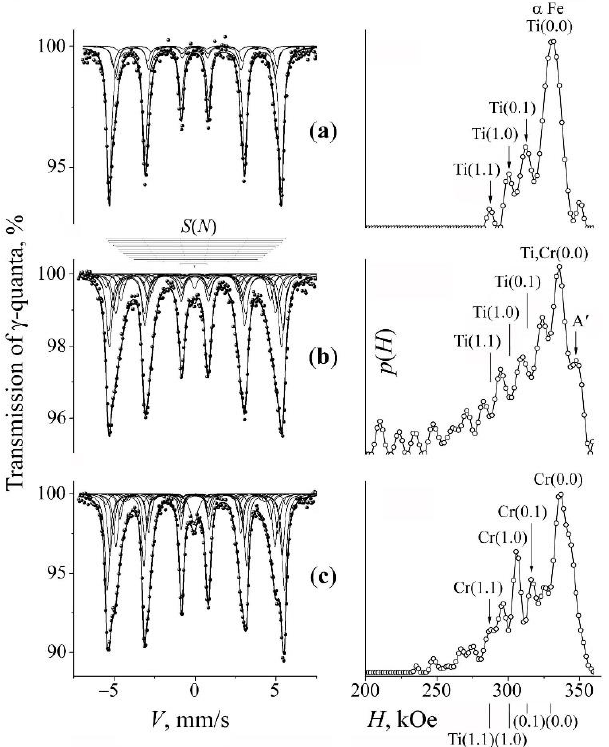
Figure 1. Mössbauer spectra of the mixture “A” (Fe–2Ti + CrN) and the distributions p ( H ) for the α -phase. Treatment: ( a ) — initial mixture; ( b ) — PBM, 10 h; ( c ) — PBM, 10 h + anneal 500 °C, 4 h. The arrows at the distribution p ( H ) mark the peaks corresponding to occupations by the impurity atoms Ti and Cr in the first two CSs of iron.